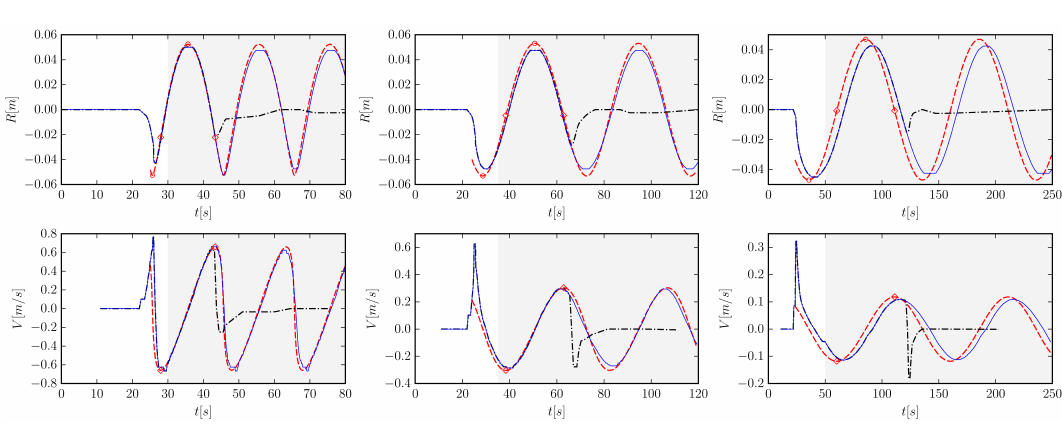
Figure 6. Time series of run-up elevation R (top) and velocity V (bottom) using analytical boundary data for three different wave shapes ( left : T20_H2; middle : T44_H3; right : T100_H4. Depicted are the theoretical evolution for periodic sinusoidal waves (red dashed), the numerical simulation with a single cycle sinusoidal wave (black dash-dotted) and the simulation with periodic sinusoidal waves (blue solid). Also shown are the positions of the theoretical maximum/minimum run-up elevations (red circles) and velocities (red diamonds) in the first period. The shaded regions depict the intervals where the extreme values for the diagrams in Figures 9 and 10 were